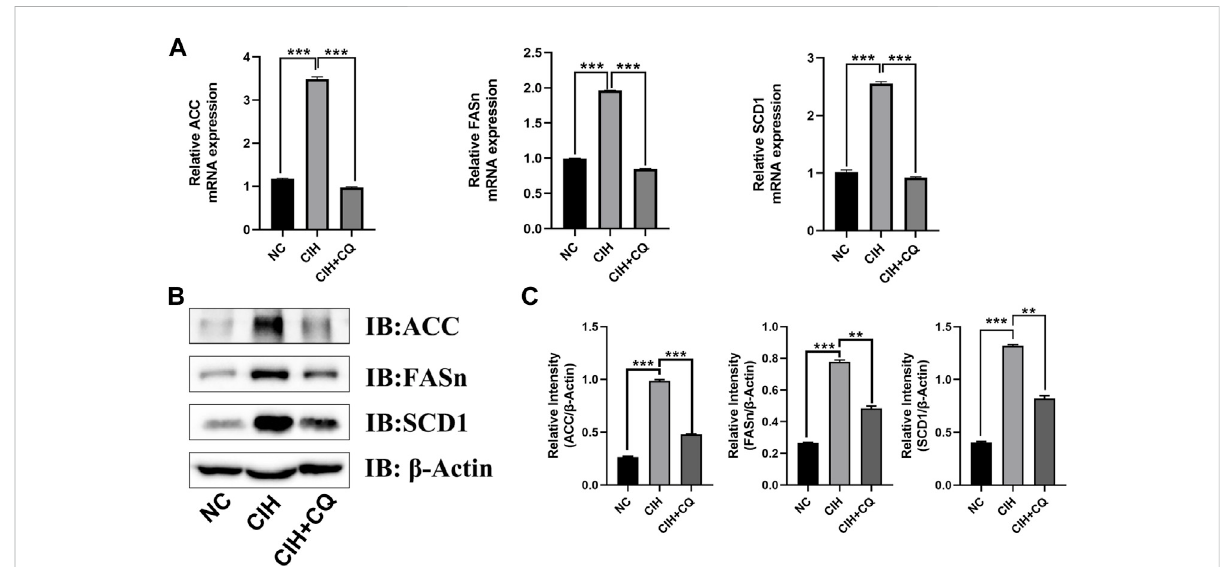
FIGURE 4 The inhibition ofautophagic fl uxreduces hepatocyte lipogenesis-relatedgene expression. (A) Hepatic SCD1, ACC,andFASn mRNA levels were compared in different groups. (B) Hepatic SCD1, ACC, and FASn protein levels were compared among groups. (C) Quanti fi cation of ACC, FAS, and SCD1 protein levels, with β -Actin serving as a normalization control (** p < 0.01, *** p < 0.001).